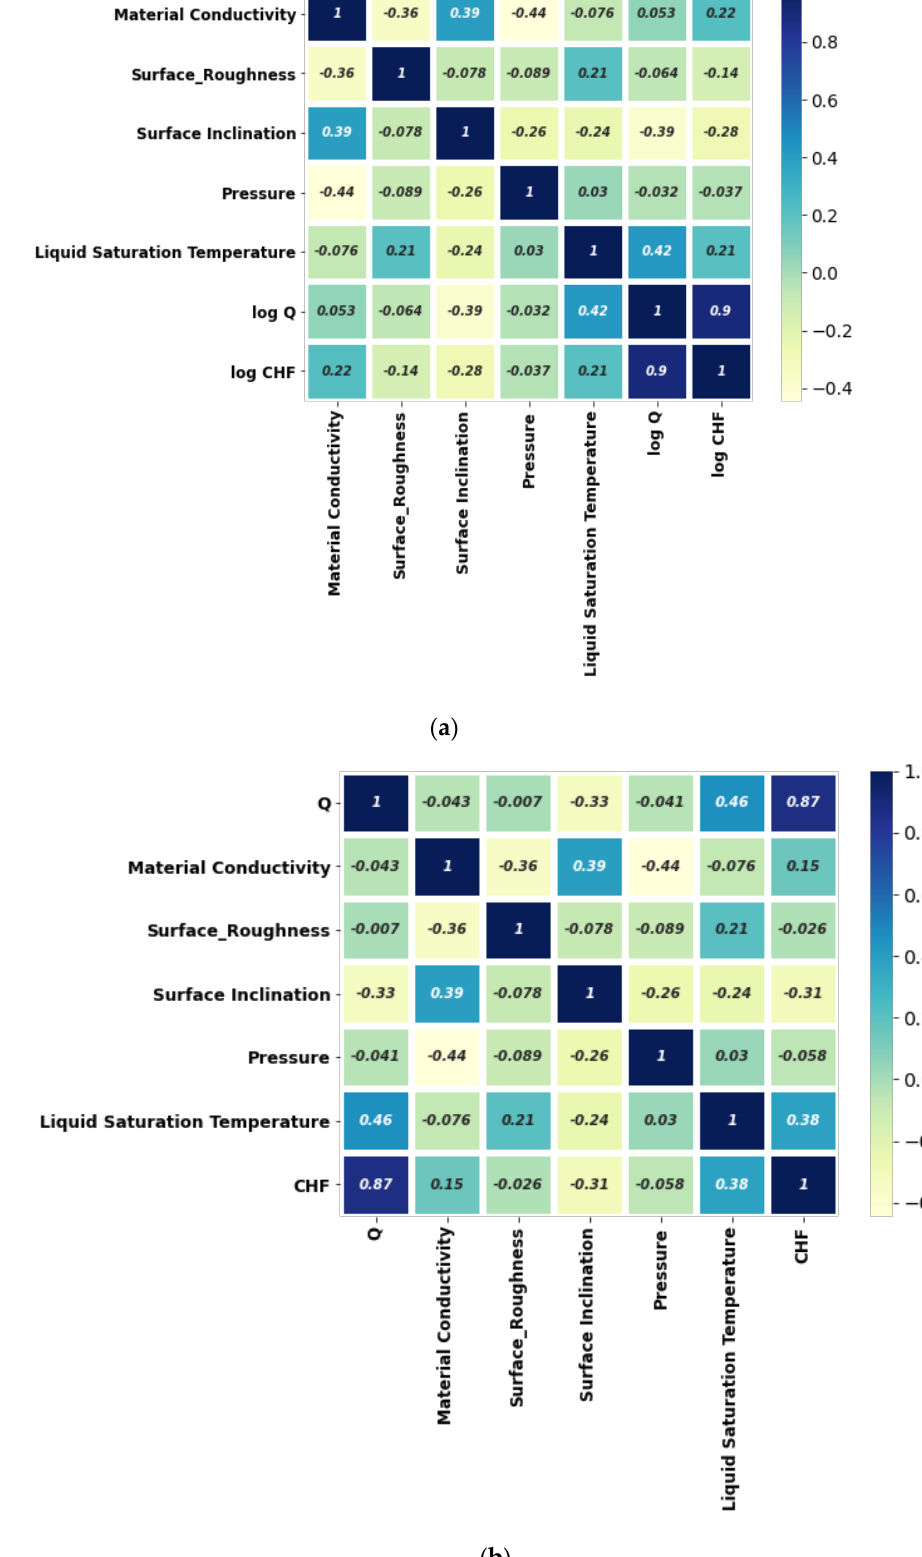
feature engineering. feature